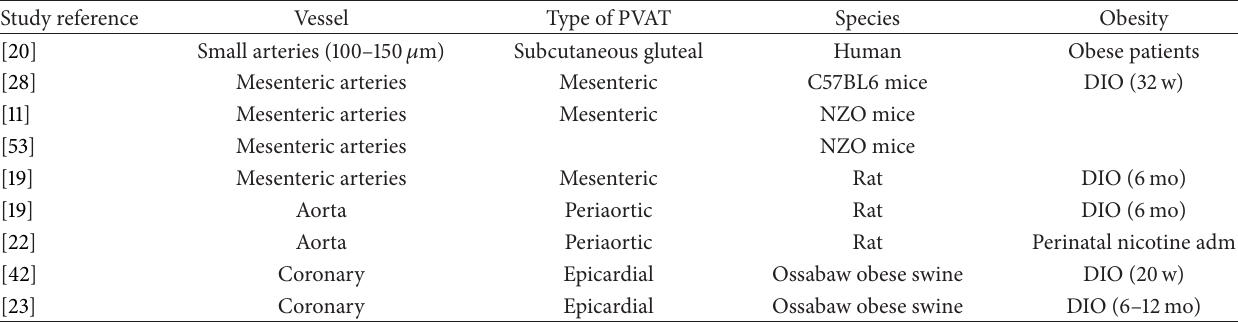
Table 2: Loss of anticontractile effect of PVAT in obesity.